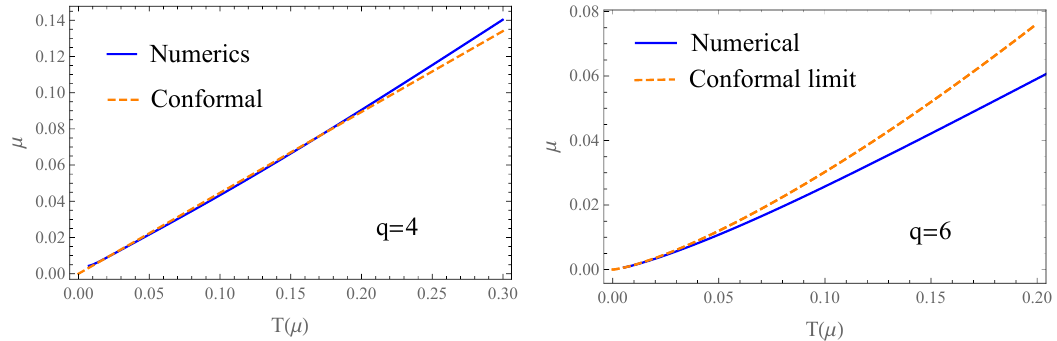
1 from variational method for low energy (cid:0)